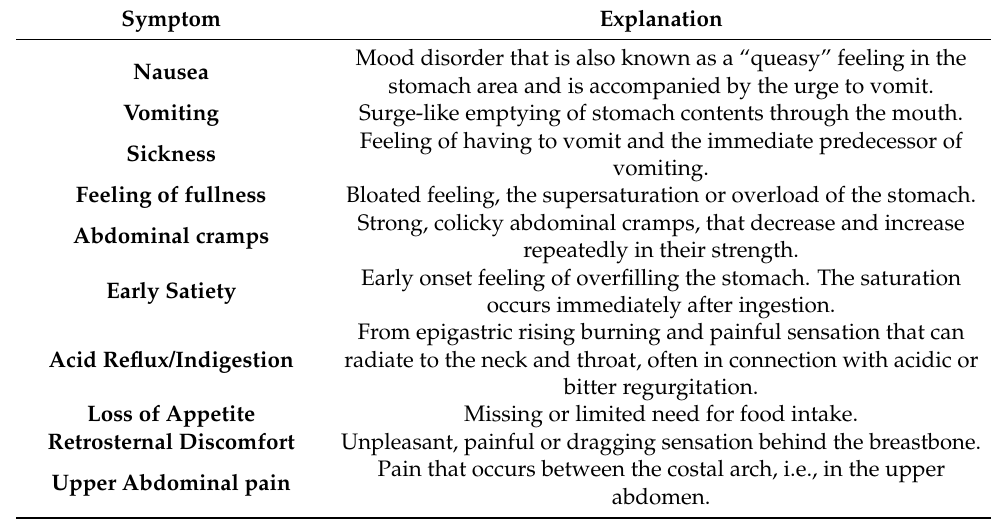
Table 1. Decision model for BWS case